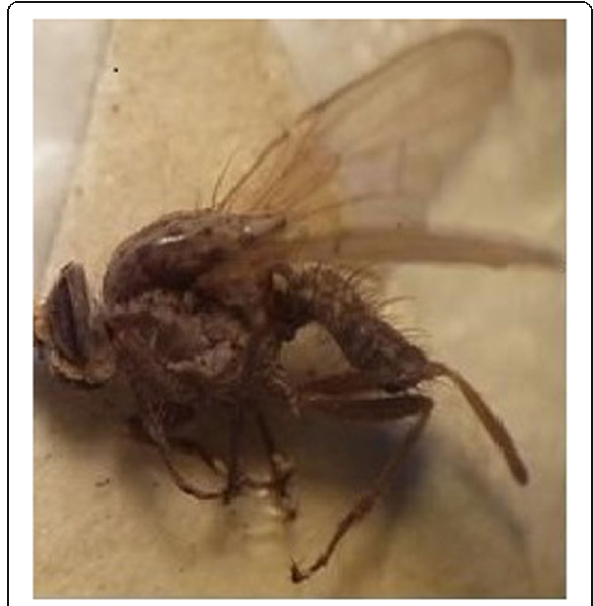
Fig. 4 Adult Scathophaga litorea : a new report in Cairo,